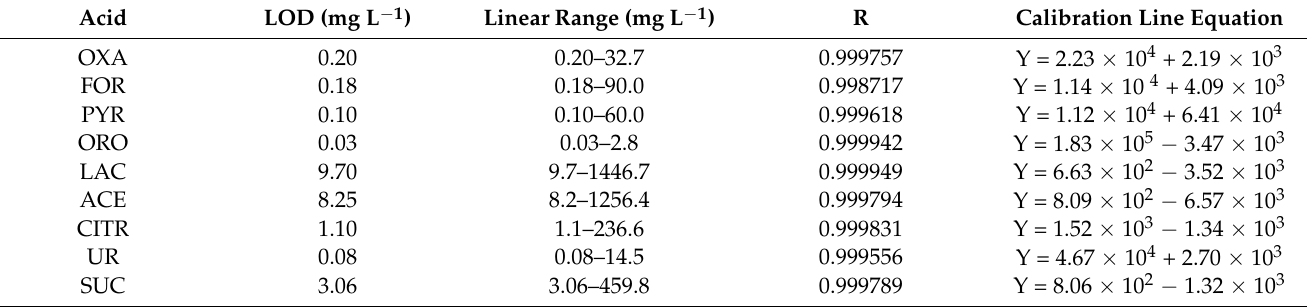
Table 1. Calibration lines for organic acids.